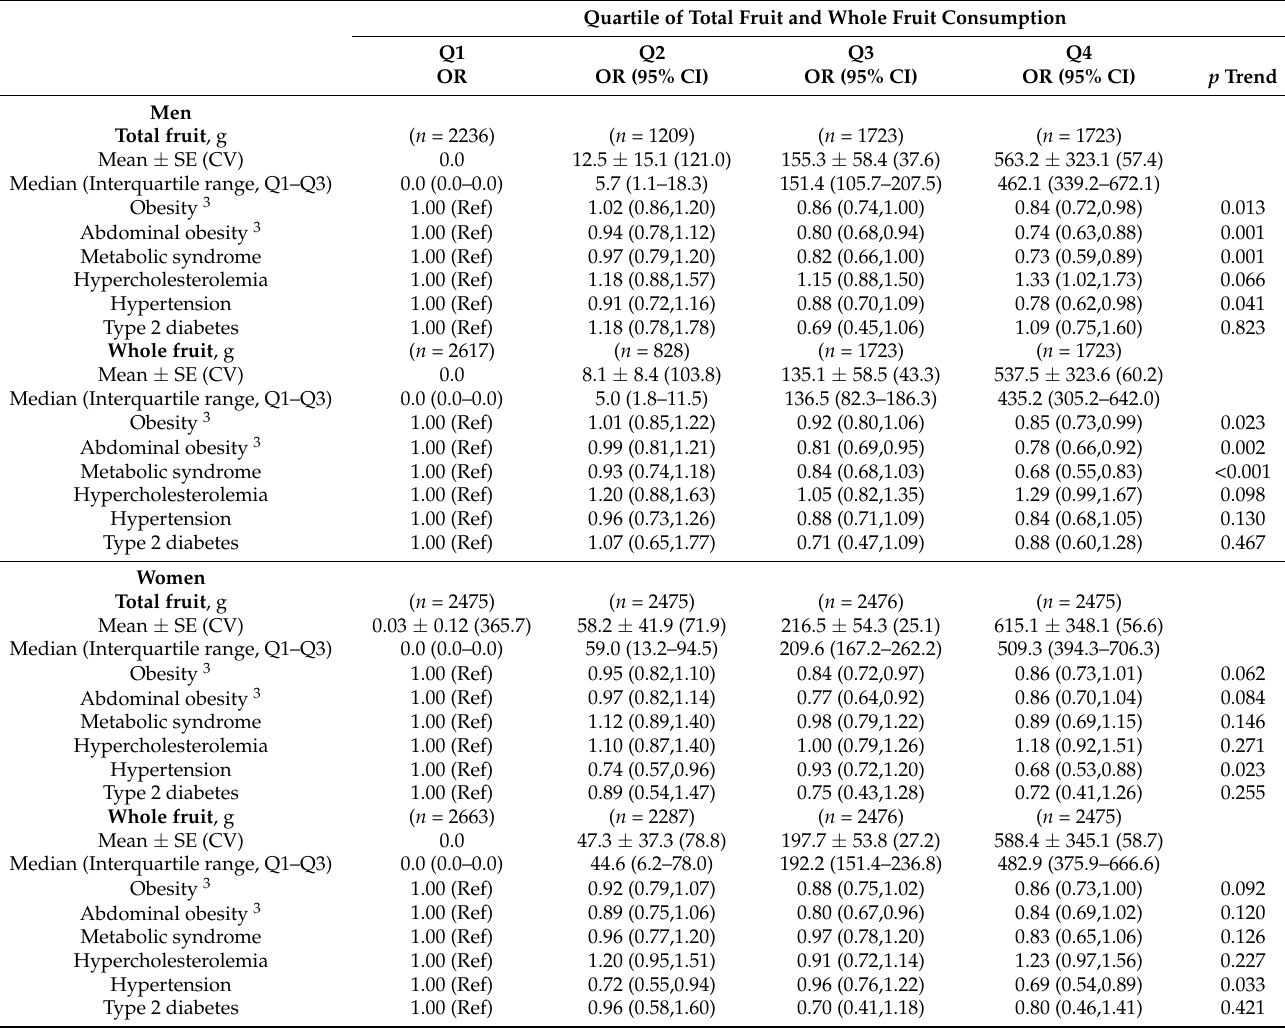
Table 5. Associations of total fruit and whole fruit consumption with cardiovascular risk factors among Korean adults by sex 1,2